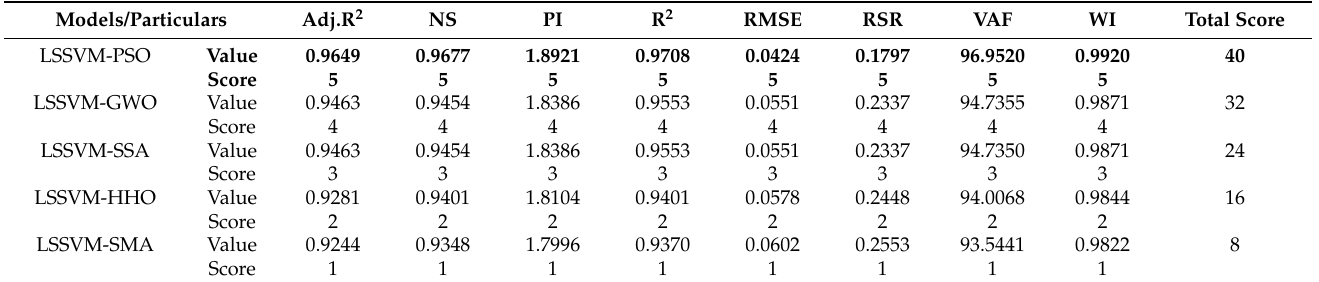
Table 6. Performance parameters for the testing dataset.